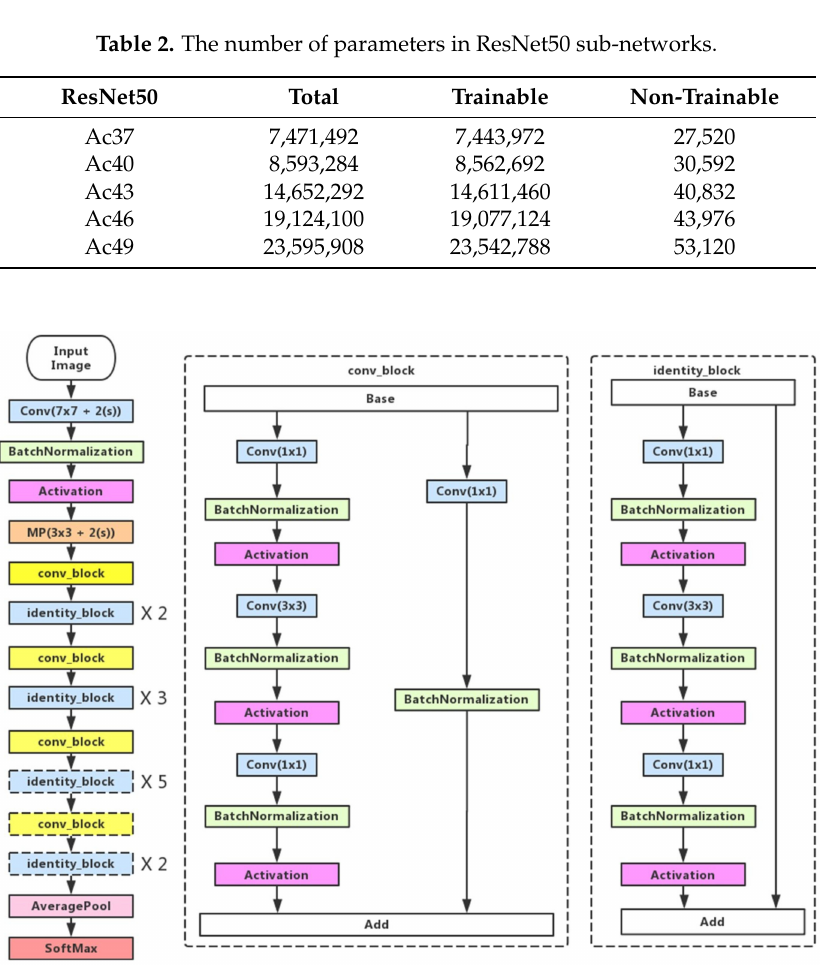
Figure 3. ( Left ) ResNet50 architecture. Blocks with dotted line represents modules that might be removed in our experiments. ( Middle ) Convolution block which changes the dimension of the input. ( Right ) Identity block which will not change the dimension of the